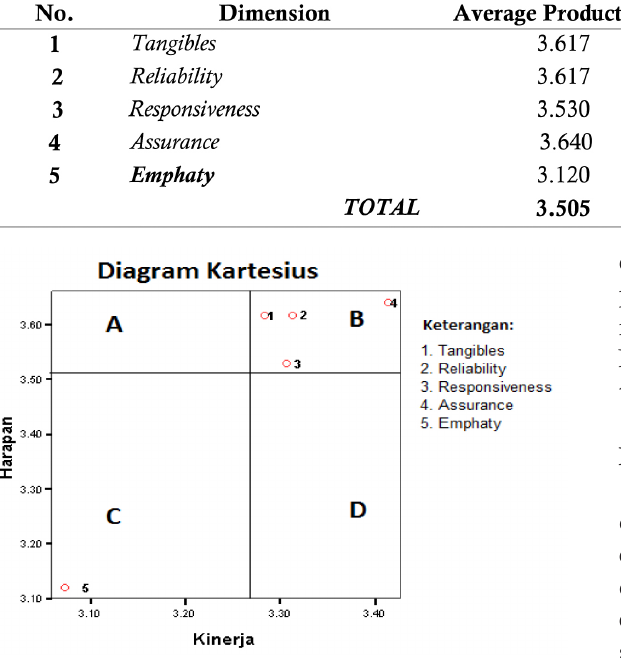
Figure2. The Result of Carthesius Diagram per Dimesion